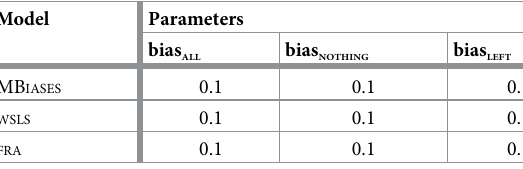
Fig 7. Simulations results. Top left: Percentage of trials on which a region was chosen and uncovered. This panel shows that, in MB IASES , the parameter bias k determines the frequency of trials on which region k is selected. Top right: Evidence of “Win Stay, Lose Shift” heuristic, which is present in both WSLS and FRA but not in MB IASES . The panel shows the boxplot of the players’ consistency on Round n for three different levels of score obtained on Round n − 1. Bottom left: Evidence of how similarity to focal regions elicits stubbornness. This mechanism is not present in MB IASES , which is reflected by the almost horizontal line in the plot. The effect of this heuristic is quite clear in FRA and WSLS . Bottom right: Qualitative behavior in terms of DL INDEX per round, averaged over 150 dyads. We can see that, while MB IASES doesn’t take off, WSLS and FRA can be quite successful in negotiating a split of the grid. The latter is more efficient than the former, due to the extra heuristic implemented by the players. https://doi.org/10.1371/journal.pone.0254532.g007 FRASim on the attractiveness function, and overall it allows for a faster convergence on a split of the grid. Finally, we can also see that the interaction between difference in consis- tency and overlap, as captured by the regression model discussed in Eq 2, behaves as expected. The interaction coefficient, β , for MB IASES is only 0.007, for WSLS rises to 0.016, 4 and goes up to 0.026 for FRA . Table 2. Parameters used in simulations shown in Fig